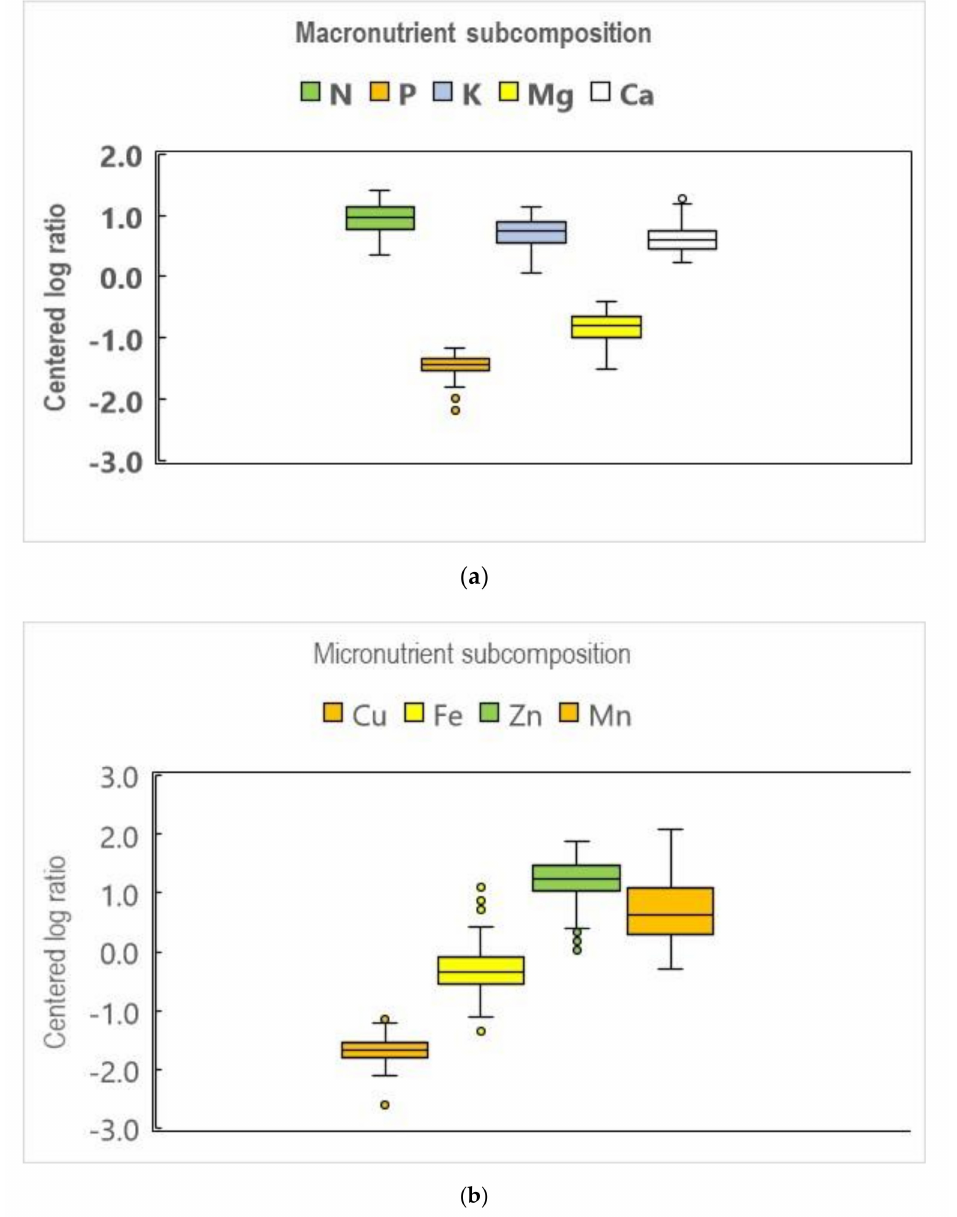
Figure 2. Boxplots of foliar centered log ratios of ( a ) macronutrient and ( b ) micronutrient subcompositions of true negative specimens peach orchards in Rio Grande do Sul, Brazil. Minus signs indicate that that nutrient concentration is lower than geometric